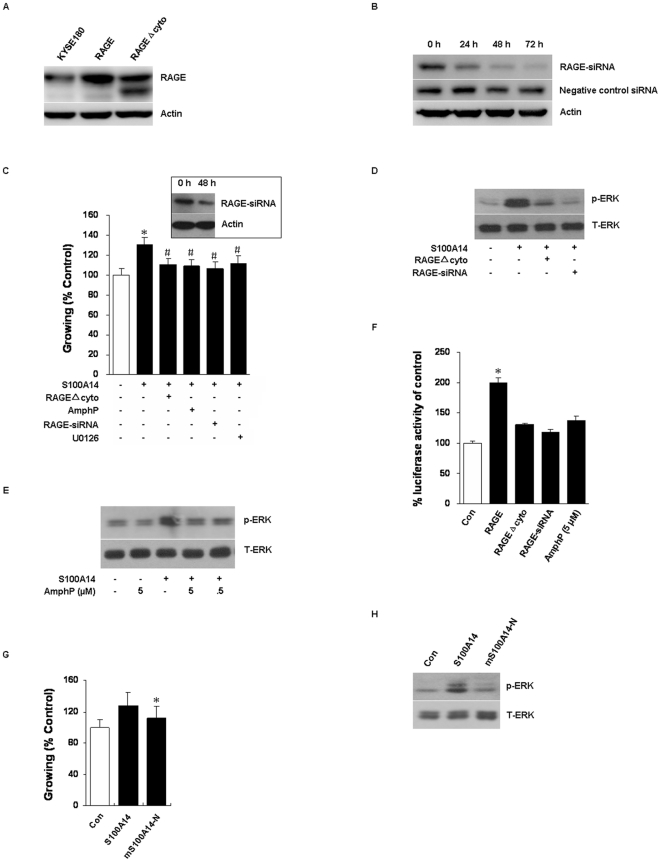
The effects of S100A14 were dependent on RAGE ligation.(A) Overexpression of RAGE and RAGEΔcyto in KYSE180 cells were confirmed by Western blot. (B) siRNA-mediated RAGE silencing in KYSE180 cells for indicated intervals was detected by Western blot. (C) KYSE180 or KYSE180-RAGEΔcyto cells were treated with 10 µg/ml S100A14 (+) or Myo117 (−) and with (+) or without (−) 5 µM AmphP or 50 nM RAGE-siRNA or 5 µM U0126 for 48 h, and the effects on cell proliferation were analyzed by MTT assays (*, P<0.05 versus control; #, P<0.05 versus S100A14). Western blot showed the effect of RAGE silence at 48 h. (D) KYSE180 or KYSE180-RAGEΔcyto or KYSE180-RAGE-siRNA cells were treated with 10 µg/ml S100A14 (+) or Myo117 (−) for 30 min, and the effects on ERK1/2 activation were estimated by Western blot. T-ERK was served as a loading control. (E) S100A14-induced ERK1/2 activation was inhibited by AmphP. KYSE180 cells were incubated with 10 µg/ml S100A14 (+) or different doses of AmphP for 30 min. (F) KYSE180-RAGE or KYSE180-RAGEΔcyto cells were treated with 10 µg/ml S100A14 (+) or Myo117 (−) or RAGE-siRNA or AmphP for 8 h, then NF-κB activity was examined by luciferase reporter assay (*, P<0.05). (G) mS100A14-N protein (mutation of N-EF hand amino acid, E39A, E45A) can not stimulate cell proliferation (*, P<0.05 versus S100A14). (H) mS100A14-N can not activate ERK1/2 in KYSE180 cells. Bars represent mean ± SD of three independent experiments.